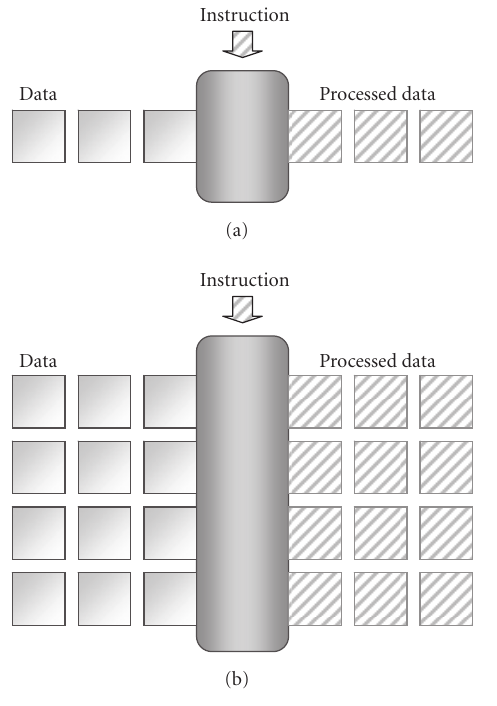
Figure 9: SISD and SIMD techniques: (a) SISD and (b) SIMD.